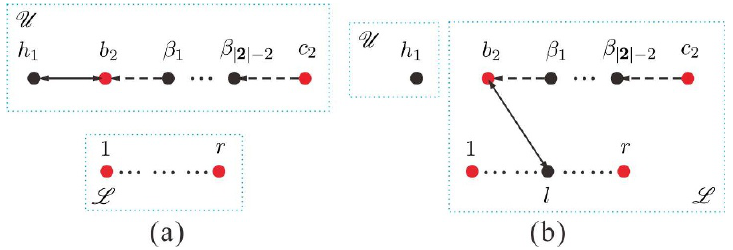
Figure 12 . Typical con(cid:12)gurations of the (cid:12)nal upper and lower blocks U , L for the skeleton (cid:12)gure 11